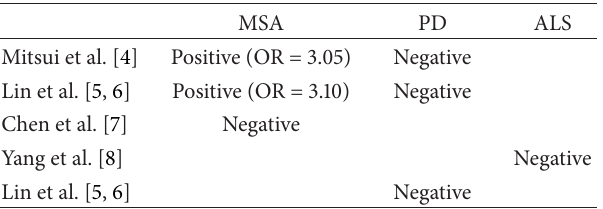
Table 4: Summary of reported COQ2 variant V393A screening in neurodegenerative